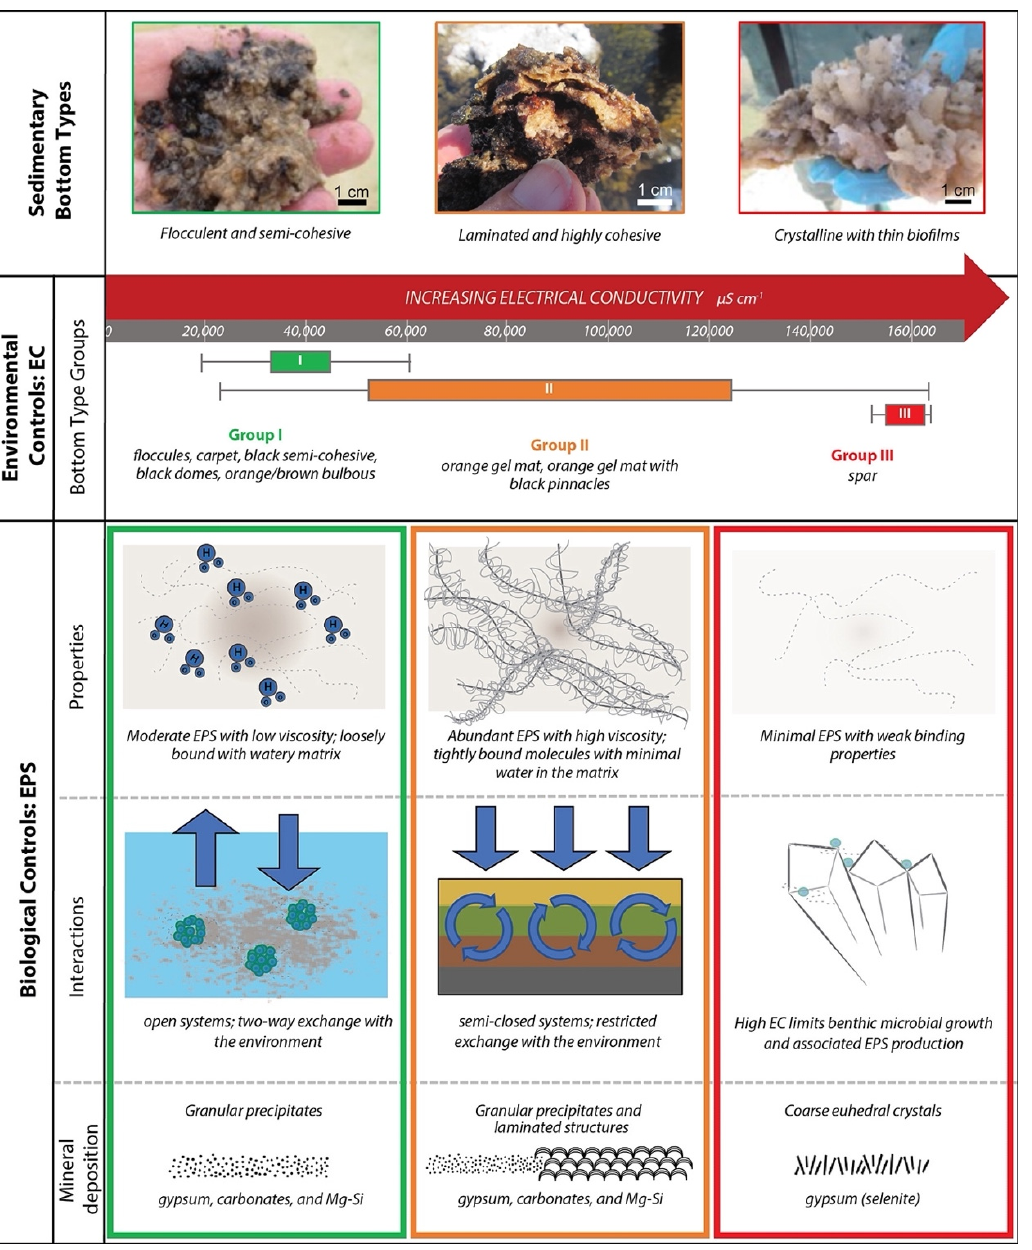
Figure 11. Summary diagram showing the effects of environmental and biological controls on bottom types, dominated by electrical conductivity and EPS in the P1/P2 subsystem of the Puquios. Group I bottom types (carpet, black domes, black semi-cohesive mat, floccules, network on bulbous mat, and orange–brown bulbous mat) are flocculent and semi-cohesive, occur in ponds with relatively low EC values, and have moderate amounts of EPS with low viscosity, which allow the microbial communities to have two-way exchange with the surrounding environment; mineral precipitates are granular and include gypsum, carbonates, and Mg–Si. Group II bottom types (orange gel mat, and orange gel mat with black pinnacles) are laminated and highly cohesive, occur in ponds with elevated EC values, and have abundant EPS with high viscosity, which allow the microbial communities to restrict exchange with the surrounding environment; mineral precipitates are granular to laminated and include gypsum, carbonates, and Mg–Si. Group III bottom types (spar) are crystalline with thin biofilms and occur in ponds with the highest EC values, where benthic microbial growth and associated EPS production are limited; mineral precipitates are coarse, often euhedral crystals of gypsum (selenite).